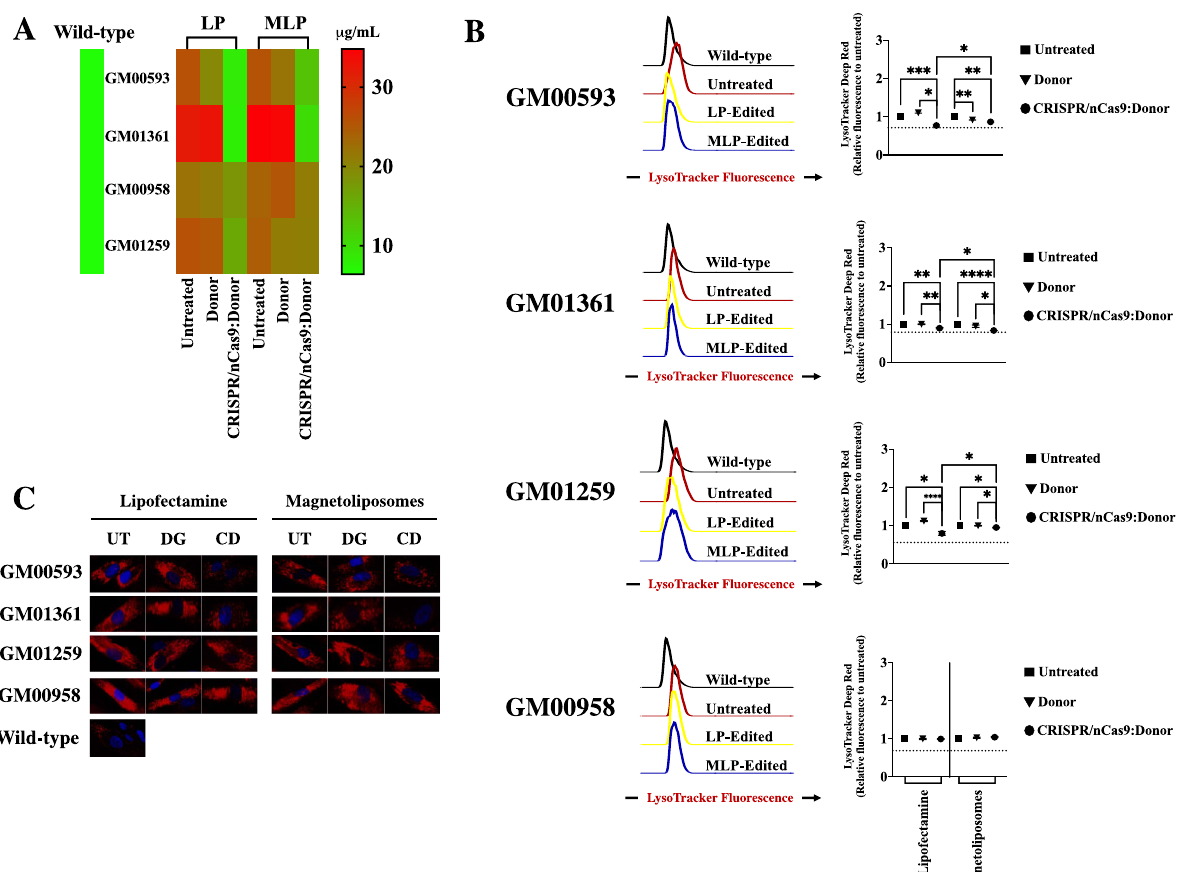
Figure 4. GAGs accumulation and lysosomal mass evaluation. ( A ) Heat map showing the global behavior of GAGs accumulation (n = 4). GM00593 and GM01361 fibroblasts showed the best recovery after CRISPR/ nCas9 system on this biomarker for both LP and MLPs. Notice an improvement on LP over MLPs for GM00593 (p = 0.0259 ), GM00958 (p = 0.0330 ) fibroblasts, and GM01259 (p = 0.0291 ) fibroblasts, when CRISPR/ nCas9 and Donor AAVS1:GALNS plasmids were transfected. Fibroblasts were transfected either with the Donor AAVS1:GALNS plasmid (Donor) or the CRISPR/nCas9-Donor AAVS1:GALNS plasmids (CRISPR/ nCas9:Donor). ( B ) Left histograms to correspond to representative findings of MFI for LysoTracker Deep Red observed on MPS IVA after CRISPR/nCas9:Donor AAVS1 treatment. The mean of relative MFI for each MPS IVA fibroblast to untreated cells (n = 4) is shown on the right. The horizontal dotted line represents the relative MFI of wild-type fibroblasts. Note that LP led a better improvement for GM00593 (p = 0.0284 ) and GM01259 (p = 0.0161 ) fibroblasts compared MLPs; while an opposite behavior was achieved for GM01361 fibroblasts (p = 0.0461 ). Fibroblasts were transfected either with the Donor AAVS1:GALNS plasmid (Donor) or the CRISPR/nCas9-Donor AAVS1:GALNS plasmids (CRISPR/nCas9:Donor). ( C ) Representative fluorescent images for LysoTracker Deep Red staining . Red fluorescence corresponds to lysosomal mass, while the blue signal to the nucleus. UT untreated, DG donor AAVS1:GALNS, CD CRISPR/Cas9 plus Donor AAVS1:GALNS. *p ≤ 0.05, **p ≤ 0.005, ***p ≤ 0.001, ****p ≤ 0.0001 . Two-tailed Student’s